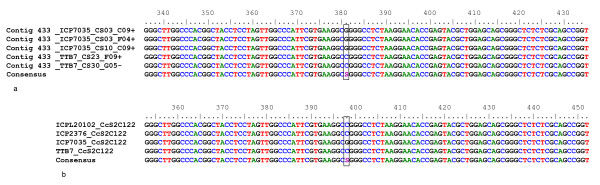
A snapshot of sequence alignment of EST sequences and amplicons for contig 433 validating the in silico predicted SNP. CAP3 alignment of ESTs (a) generated from 'ICP 7035' and 'TTB 7'in contig 433 showing a SNP between these genotypes and (b) Multiple sequence alignment of amplicon sequences generated from genomic DNA of four genotypes ('ICPL 20102', 'ICP 2376', 'ICP 7035' and 'TTB 7') with the primer pairs for the assembled contig 433. The in silico identified SNP in the EST contig 433 was confirmed in the amplicon sequences.